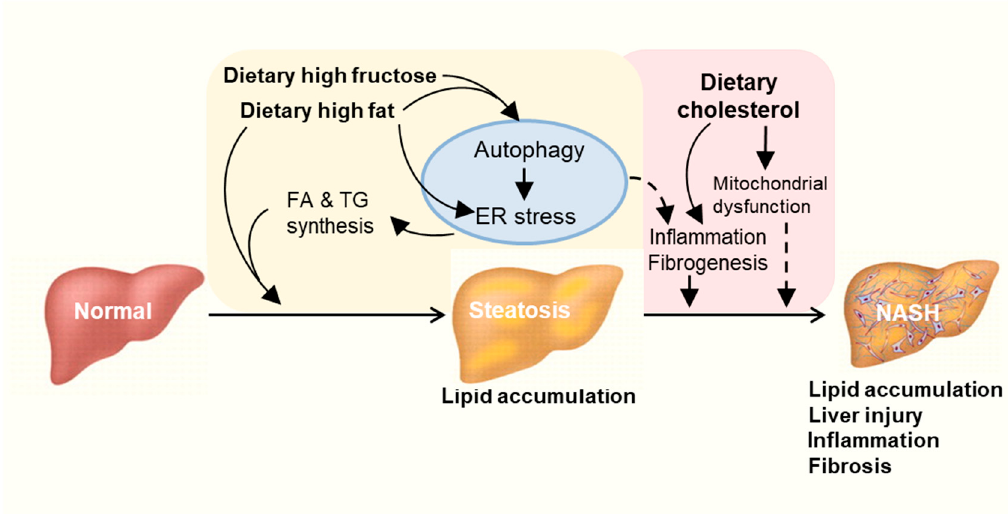
Figure 3. Proposed autophagy-ER stress-inflammation in the pathogenesis of NAFLD induced by overconsumption of dietary fat and fructose. High fat or high fructose consumption can cause excessive lipid accumulation in the liver known as hepatic steatosis. Cholesterol consumption can aggravate hepatic inflammation and fibrosis possibly independent of autophagy and ER stress. Multiple mechanisms are involved in the development and exacerbation of NAFLD including autophagy, endoplasmic reticulum (ER) stress and inflammatory responses. FA: fatty acid. TG: triglyceride.